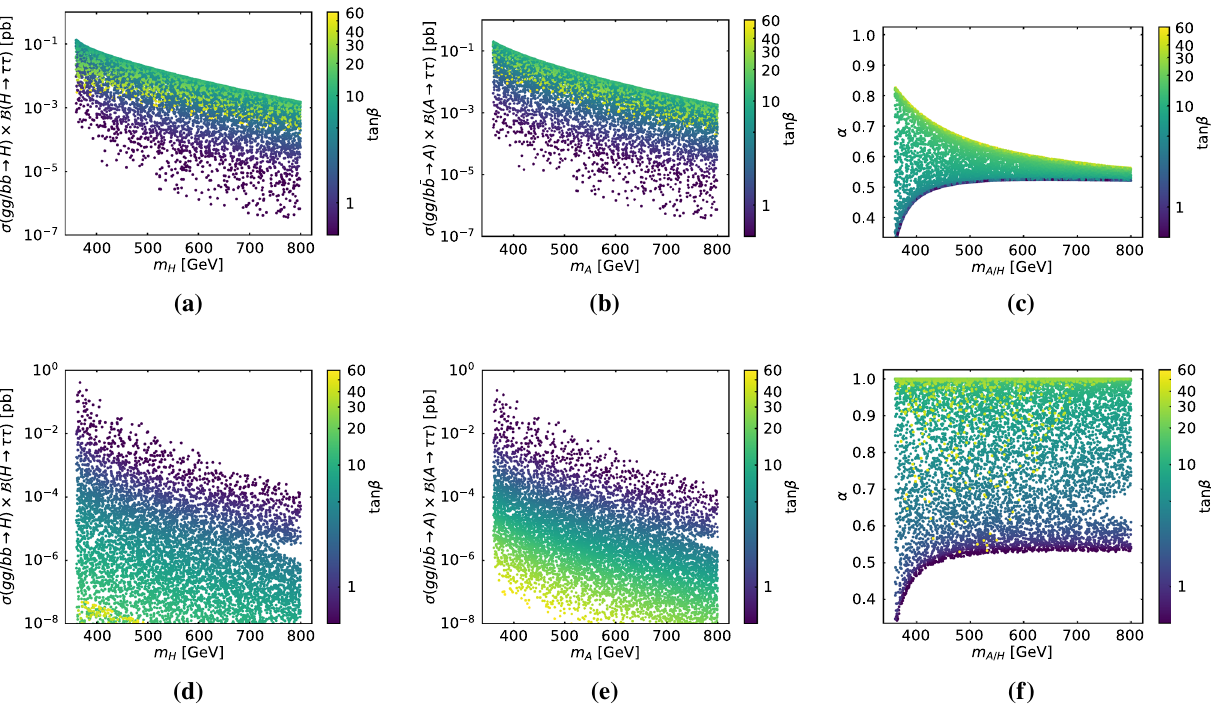
Fig. 7 Top row, lepton-specific THDM: a Signal strength for pp → H → ττ , as a function of m H and tan β . b Similar result for pp → A → ττ . c The ratio of the signal strength of pp → A → ττ to the total ditau signal strength, as defined in Eq. (1). Bottom row: Corresponding results within the type-I